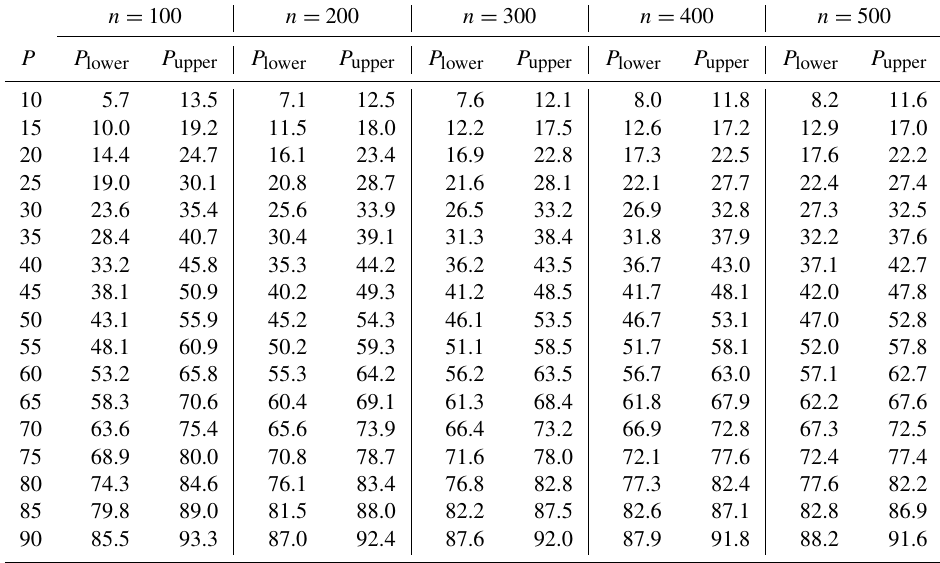
Table B3. Upper and lower percentile confidence interval bounds for α = 0 . 20 (80% confidence level).